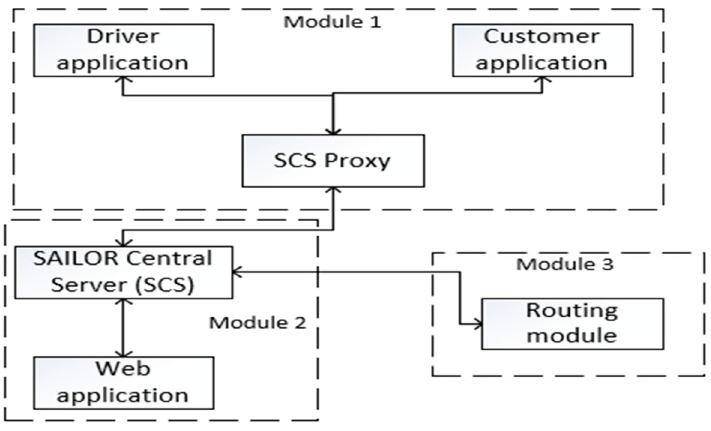
Figure 2. System Figure 2. System deployment.